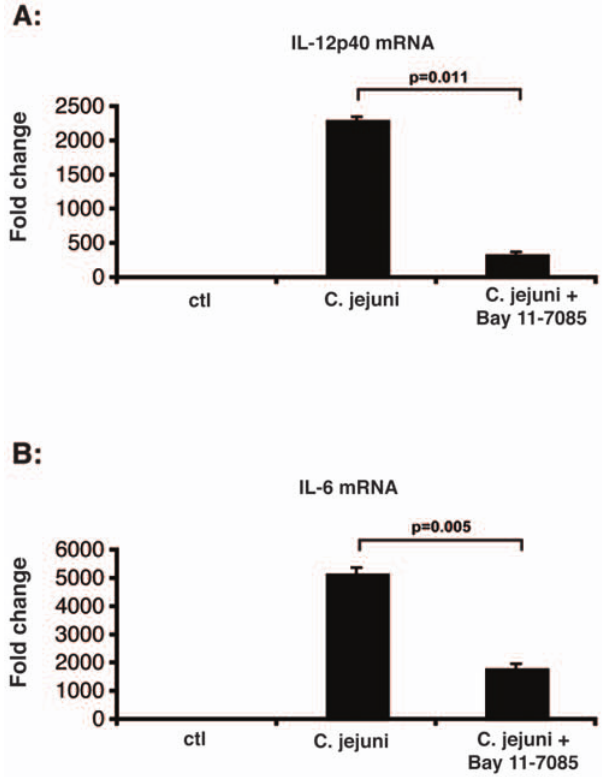
Figure 2. NF- k B signaling drives C.jejuni induced cytokine gene expression in BMDC. BMDC were generated from WT mice and treated with Bay 11-7085 (10 m M) and then stimulated with C. jejuni (MOI 50) for 4 h. Cells were lysed in Trizol, total RNA was extracted, reverse transcribed and IL-12p40 (A) and IL-6 (B) mRNA expression was detected using real-time PCR (Applied Biosystems 7700 sequence detection system). Results were normalized to the housekeeping gene GAPDH to ascertain similar loading. Results are the mean + / 2 SD of triplicates samples and are from one of three independent experiments (*p=0.011 for IL-12p40 vs. Bay 11-7085-treated cells; *p=0.005 for IL-6 vs. Bay 11-7085-treated cells).